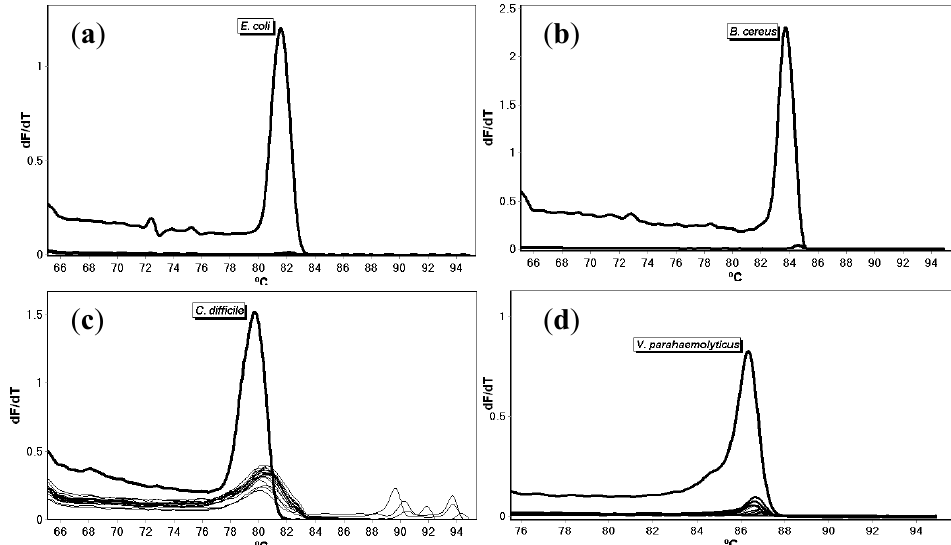
Figure 3. Melt curves for: ( a ) E. coli; ( b ) B. cereus; ( c ) C. difficile; and ( d ) V. parahaemolyticus primers tested with DNA from 18 bacterial species and human DNA.